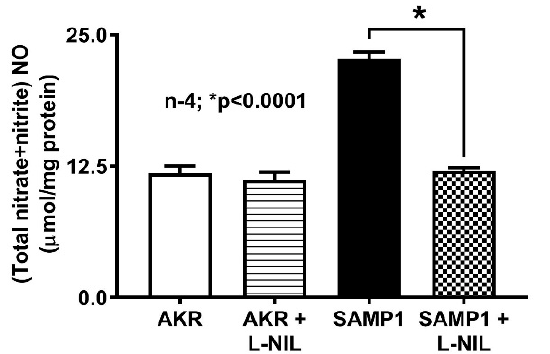
Figure 3. Effect of N6-(1-iminoethyl)-L-lysine dihydrochloride (L-NIL) on intracellular NO levels. NO level was significantly increased in ileal villus cells of SAMP1 mice compared to control AKR mice. L-NIL treatment reversed the stimulation of intracellular NO levels in SAMP1 mice, and had no effect on NO levels in villus cells from AKR mice.